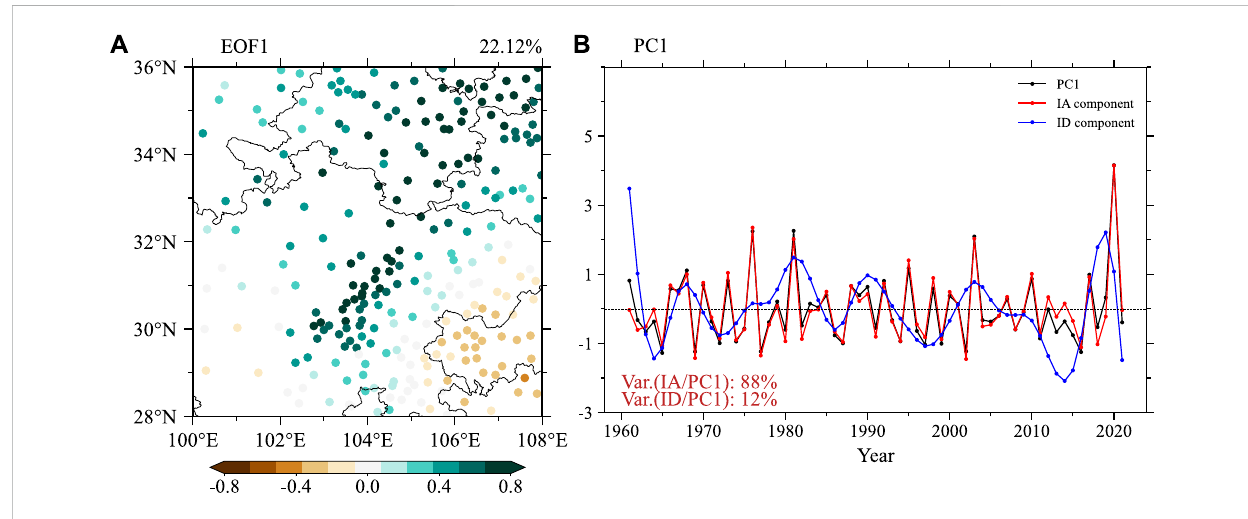
FIGURE 4 (A) Spatial pattern and (B) the principal component (PC, black line) of the fi rst EOF mode of late summer extreme precipitation in WC from 1961 to 2021. The red and blue lines in (B) are the interannual and interdecadal components of PC1,